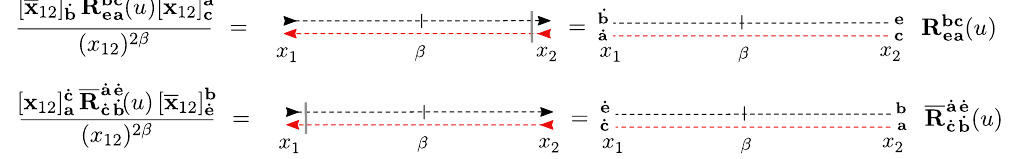
Figure 5 . Graphic representation of the propagator S stand for the spinorial structures in (2.16), and the mixing matrix R (or R ) is inserted along their structure as a solid grey line. On the right we show the explicit spinor structure of S corresponding to the compact notation on the